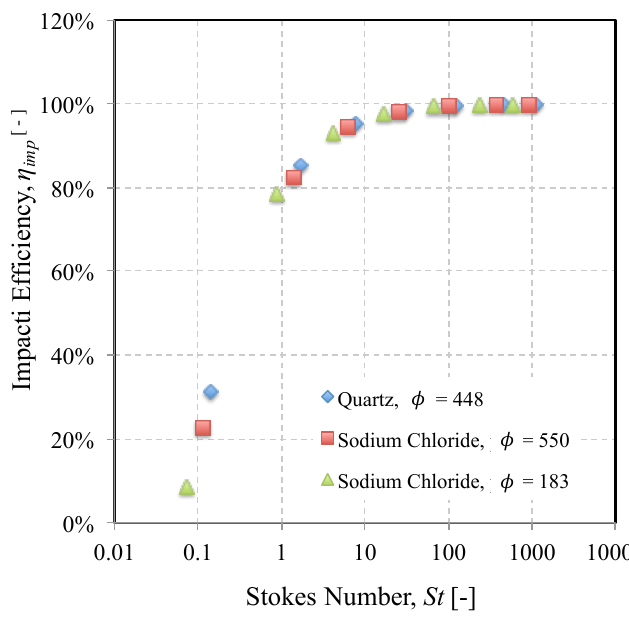
Figure 8. Impact efficiency as a function of Stokes number of two constituent minerals of the AFRL02 test dust and three different values of φ .